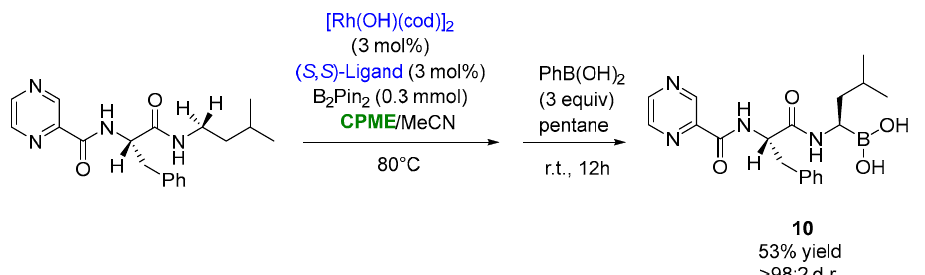
8 of 31 Figure 8. Asymmetric α -borylmethyl oxindoles from o -iodoanilides. The use of CPME appeared to also be productive, in a mixture 1:1 with MeCN, in the optimized synthesis of bortezomib (( 10 ), Figure 9), an anti-cancer drug consisting of three structural units linked together by peptide bonds: pyrazinoyl, L -phenylalanyl and L -